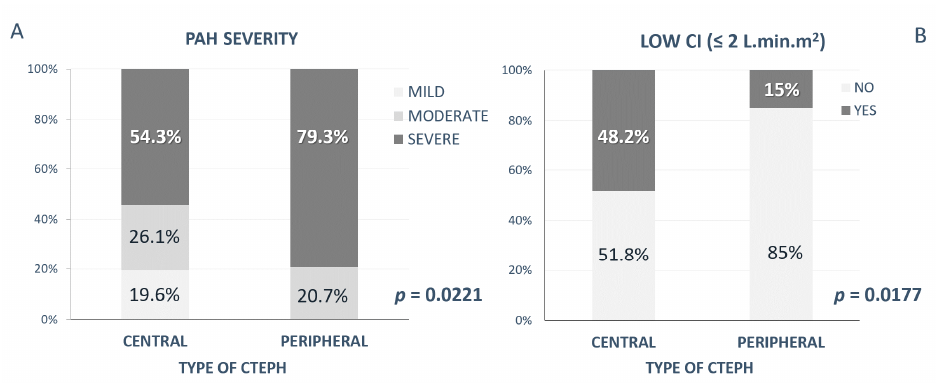
Figure 3. Differences in Group 1 (CENTRAL type) vs. Group 2 (PERIPHERAL type) in: ( A ) invasively assessed PAH severity; ( B ) the presence of low CI ( ≤ 2 L.min.m 2 ). CTEPH—chronic thromboembolic pulmonary hypertension; CI—cardiac index; and PAH—pulmonary arterial hypertension.